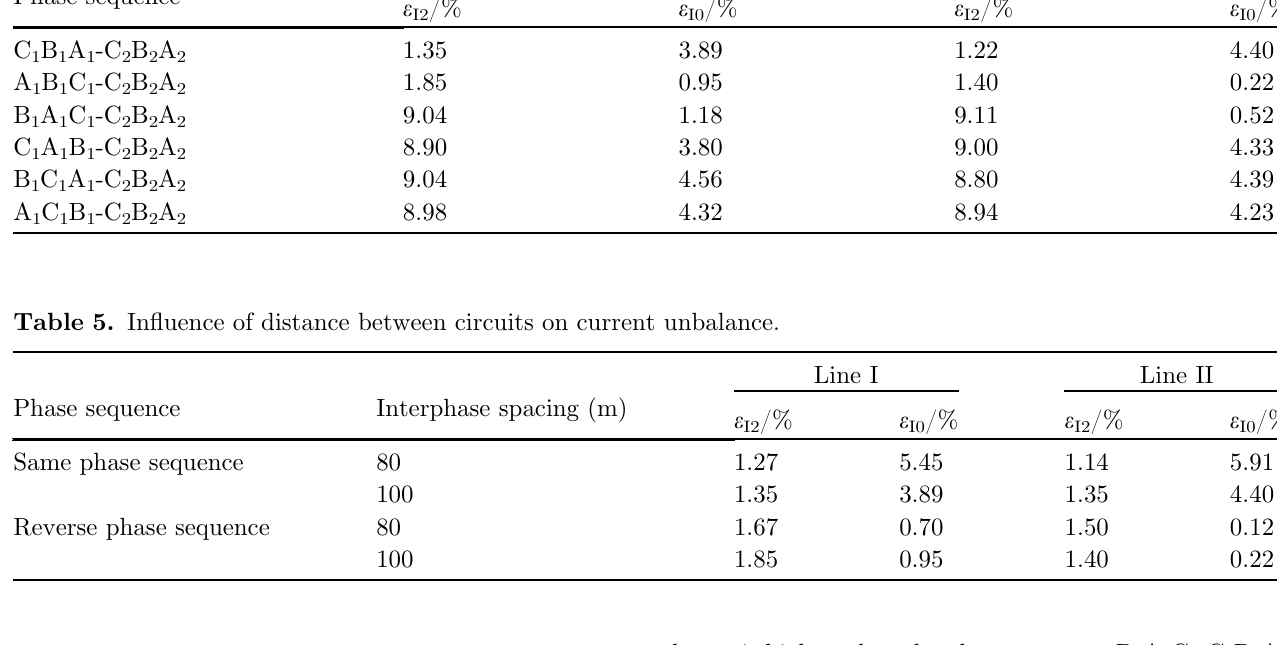
Table 4. Current unbalance degree under different phase sequence arrangement modes of the line. Phase sequence